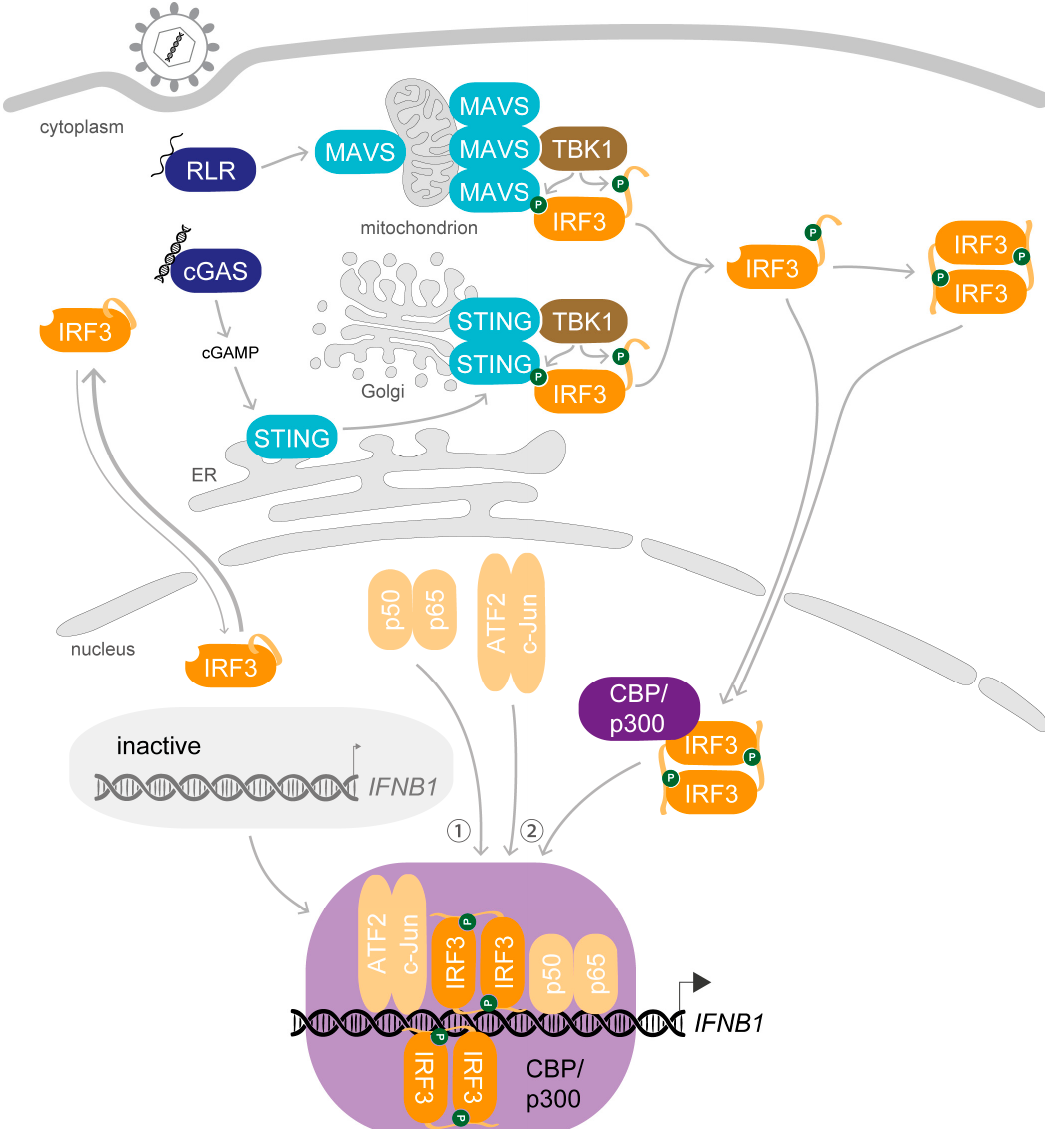
Figure 2. IRF3 activation induces transcription of IFNB1 upon viral infection. In resting cells, latent IRF3 shuttles between the cytosol and nucleus. Upon viral infection, viral nucleic acids are